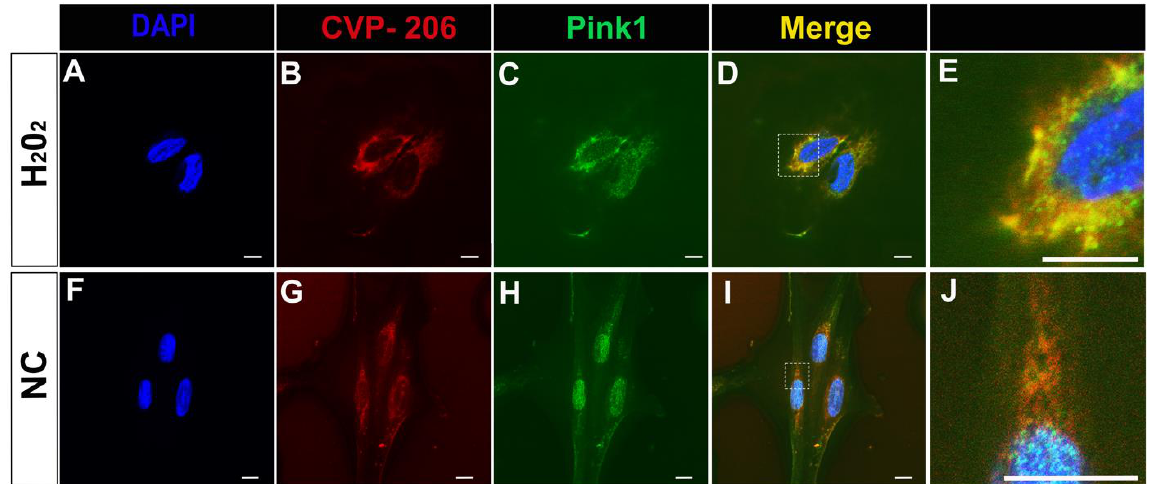
Figure 4. Colocalization of Pink1 and CVP-206 peptide in H9c2 cells. ( A – E ) Immunostaining for CVP-206 (1 µM, Red) and Pink1 (Green) after H 2 O 2 treatment (1.6 mM for 0.5 h). ( E ) Higher magnification of D. ( F – J ) Immunostaining for Pink1 (Green) and CVP-206 (1 µM, Red) in H9c2 cells with no treatment, Negative control (NC). ( J ) Higher magnification of I. Nuclei are in blue (DAPI), scale bar indicates 5 µm for CVP-206 staining after H 2 O 2 , and 10 µm for negative control (NC) and MitoTracker ( n = 3). Confocal microscopy images were taken at 63× magnification for NC and H 2 O 2 treated cells.